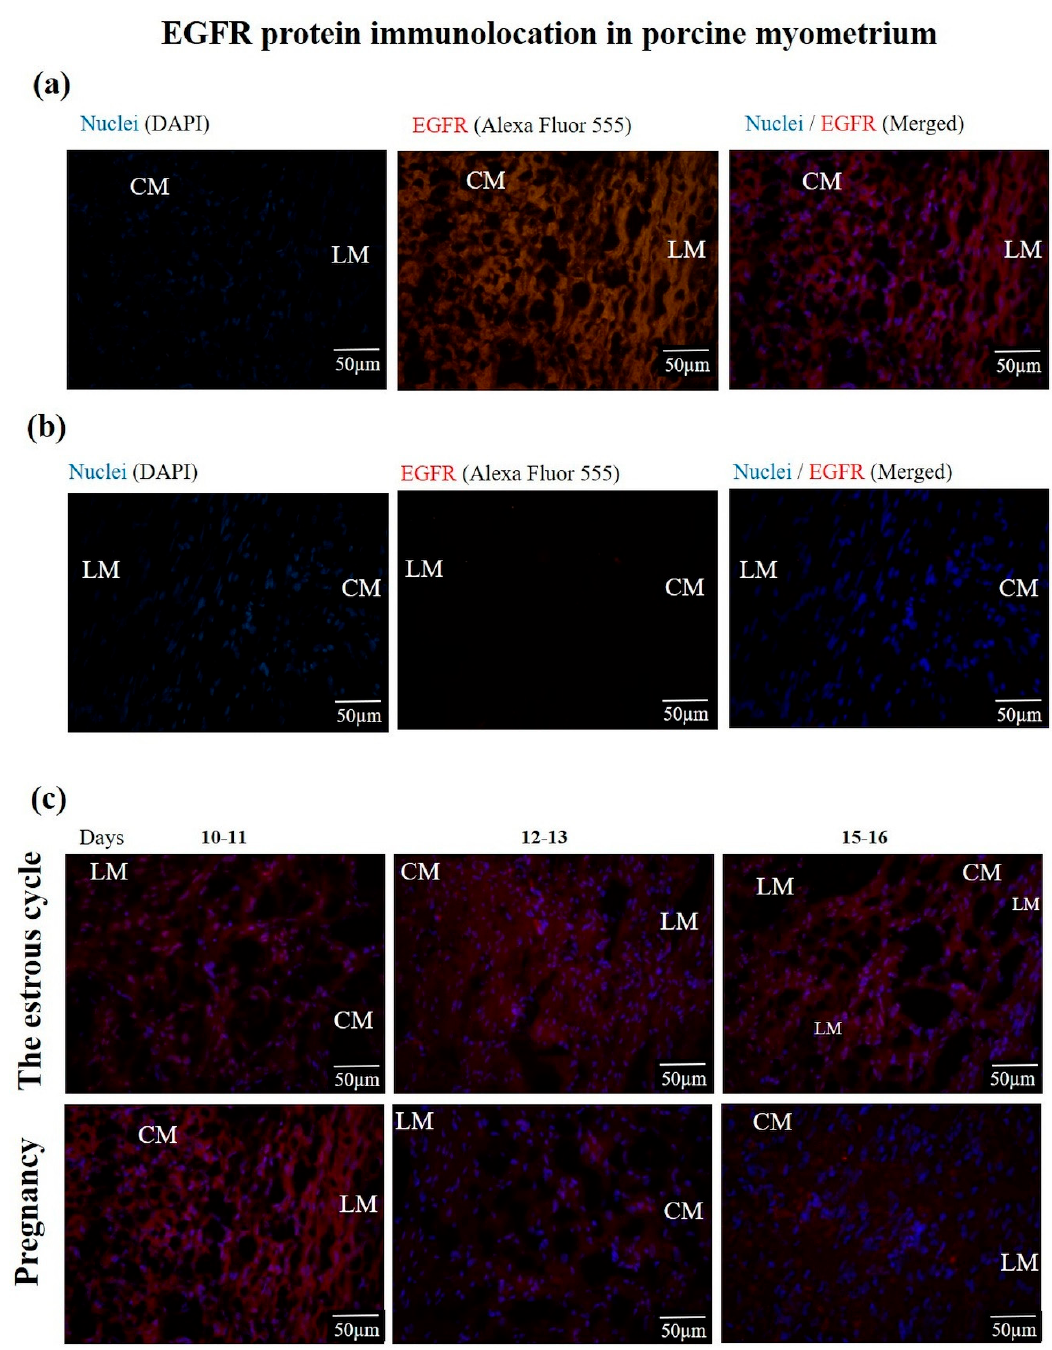
Figure 4. The representative photographs showing ( a ) EGFR immunostaining, ( b ) negative control, and ( c ) the myometrial location of EGFR during days 10–11, 12–13 and 15–16 of the estrous cycle and days 10–11, 12–13 and 15–16 of pregnancy. Magnification 400×. CM—circular muscle; LM—longitudinal muscle. The nuclei are stained with DAPI ( blue ) and EGFR sites are stained with Alexa Fluor 555 ( red ).